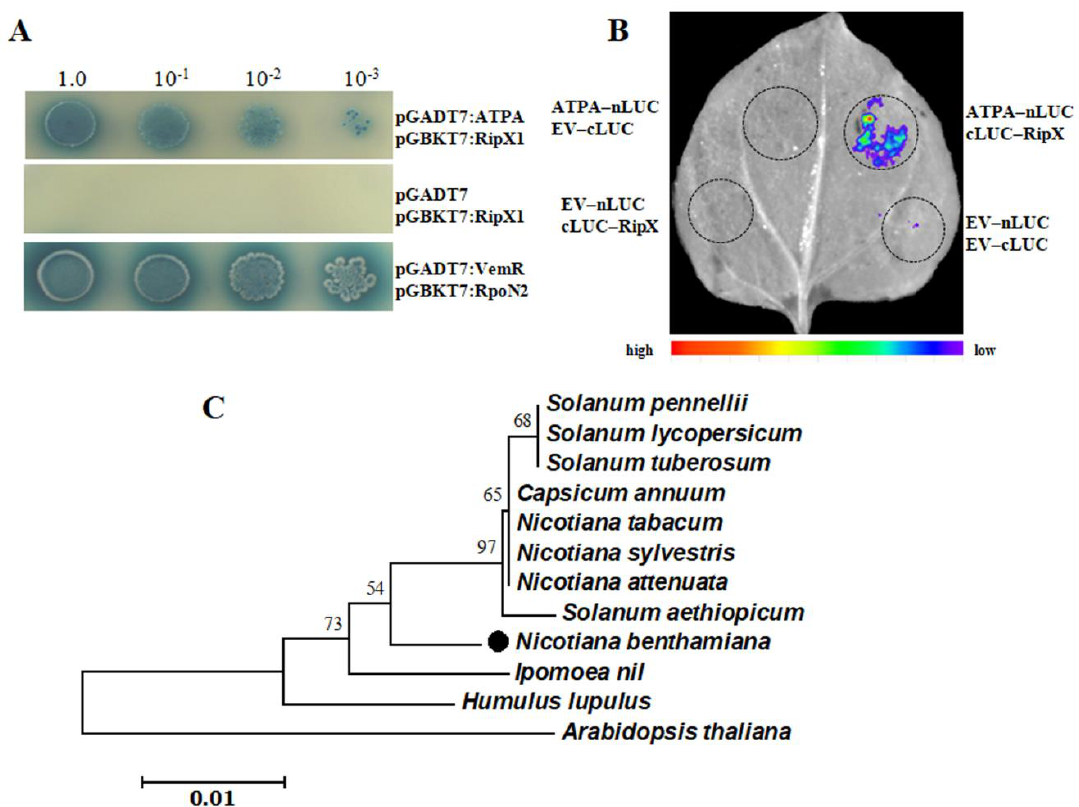
Figure 3. Identification of the ATPA protein that interacted with RipX1. ( A ) Y2H assays showing the interaction between ATPA and RipX1. The yeast strains were grown on SD / -Ade / -Leu / -Trp / -His / plates supplied with X- α -galactosidase. The interaction between VemR and RpoN2 was used as a positive control. Y2H assays were repeated three times. ( B ) Split-luciferase assays of the interaction of ATPA with RipX1. This experiment was repeated three times, with similar results. Relative light units are shown below. ( C ) Evolutionary relationships of 12 ATPAs from representative plant species.